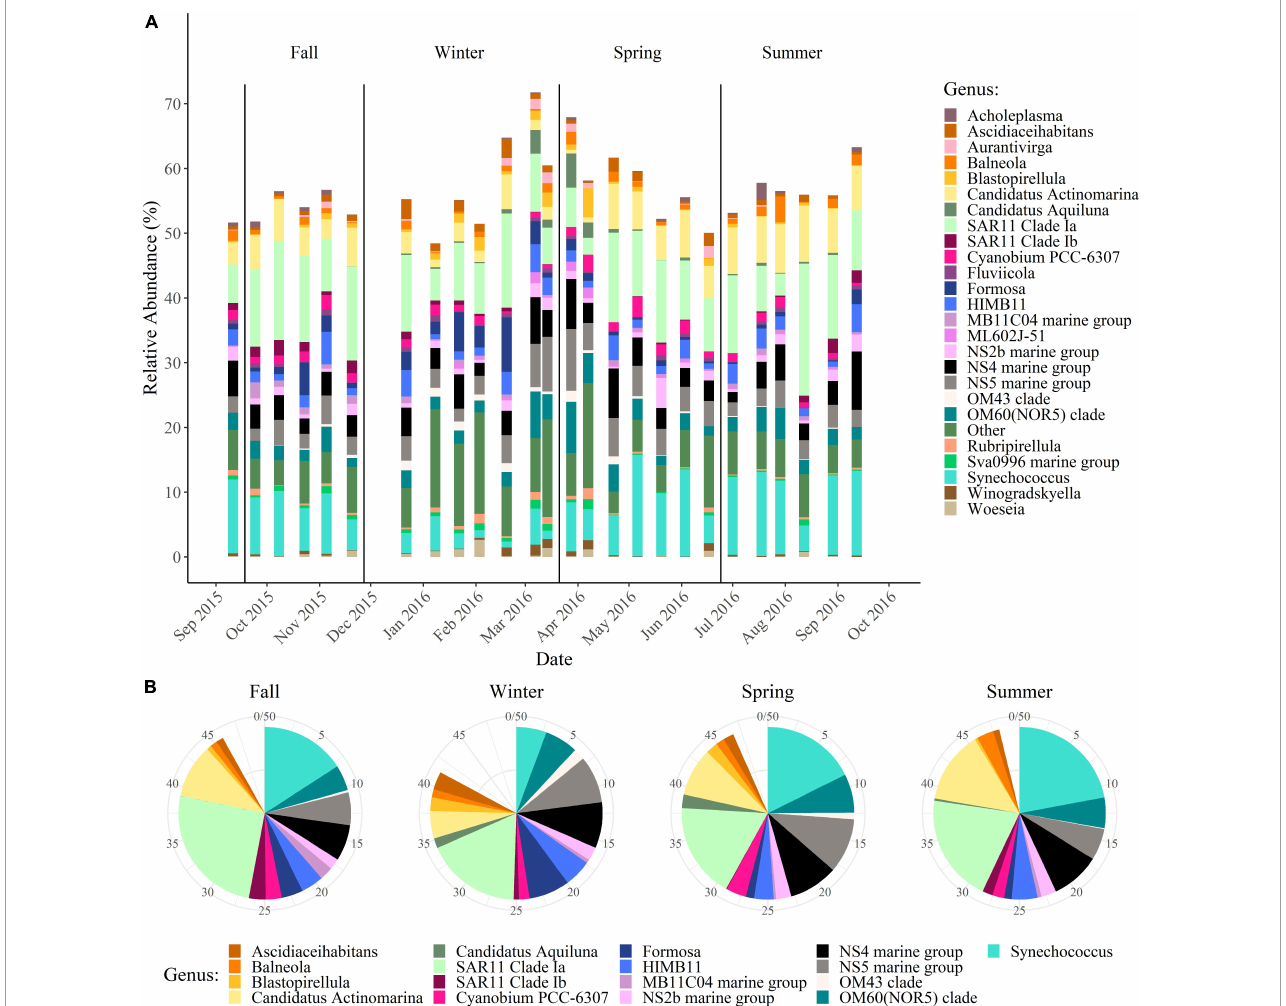
FIGURE3 Shifts in the most abundant bacterial genera. Taxonomy was assigned using RDP’s Naïve Bayesian classifier and the SILVA138 reference database. (A) Changes in the top 25 most abundant genera by date. (B) Changes in the dominant genera ( > 1% average relative abundance) between